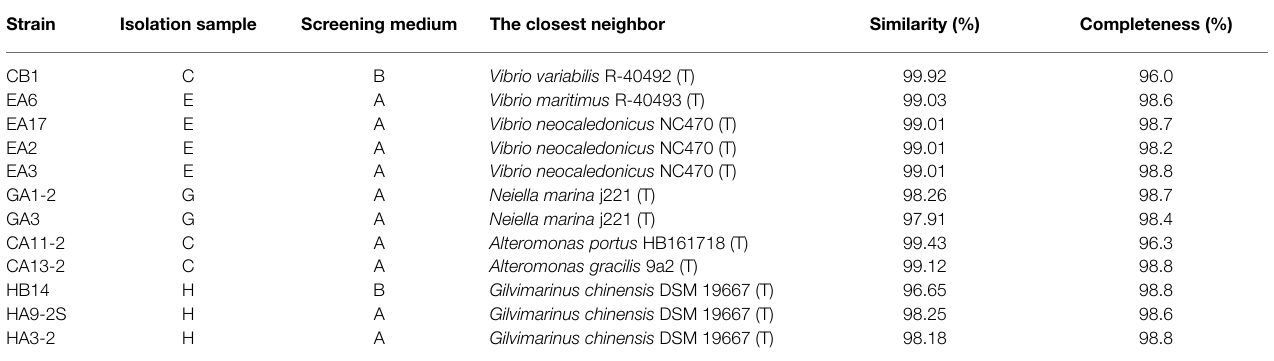
TABLE 3 | Information of the isolated 1,3-xylanase-secreting bacteria.